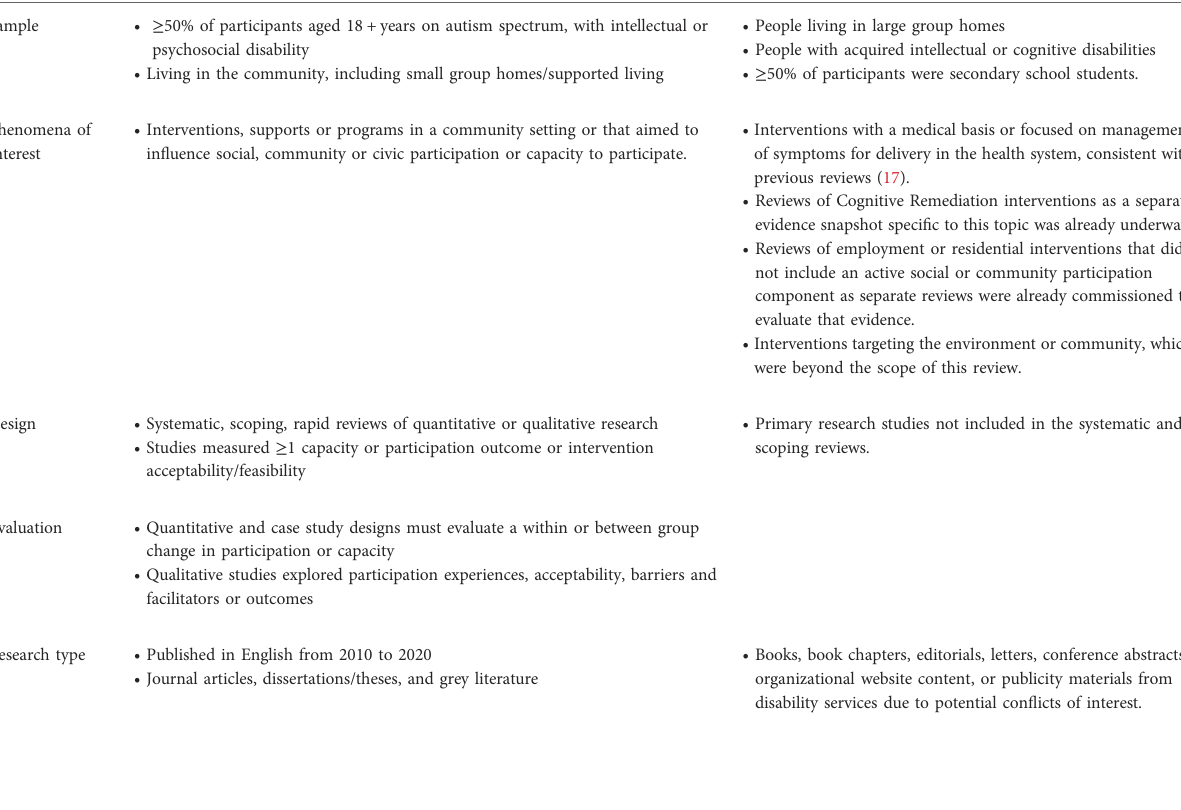
TABLE 1 SPIDER eligibility criteria for the umbrella review. Domain Inclusion